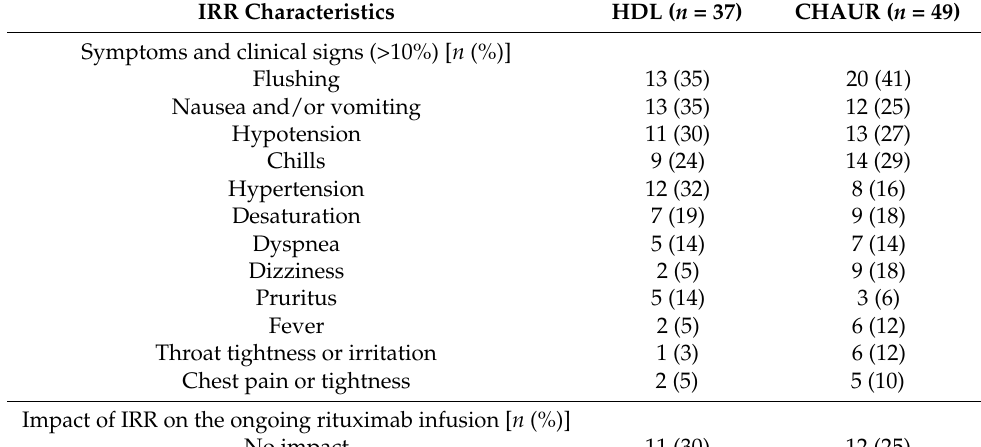
Table 2. Infusion-related reaction characteristics.